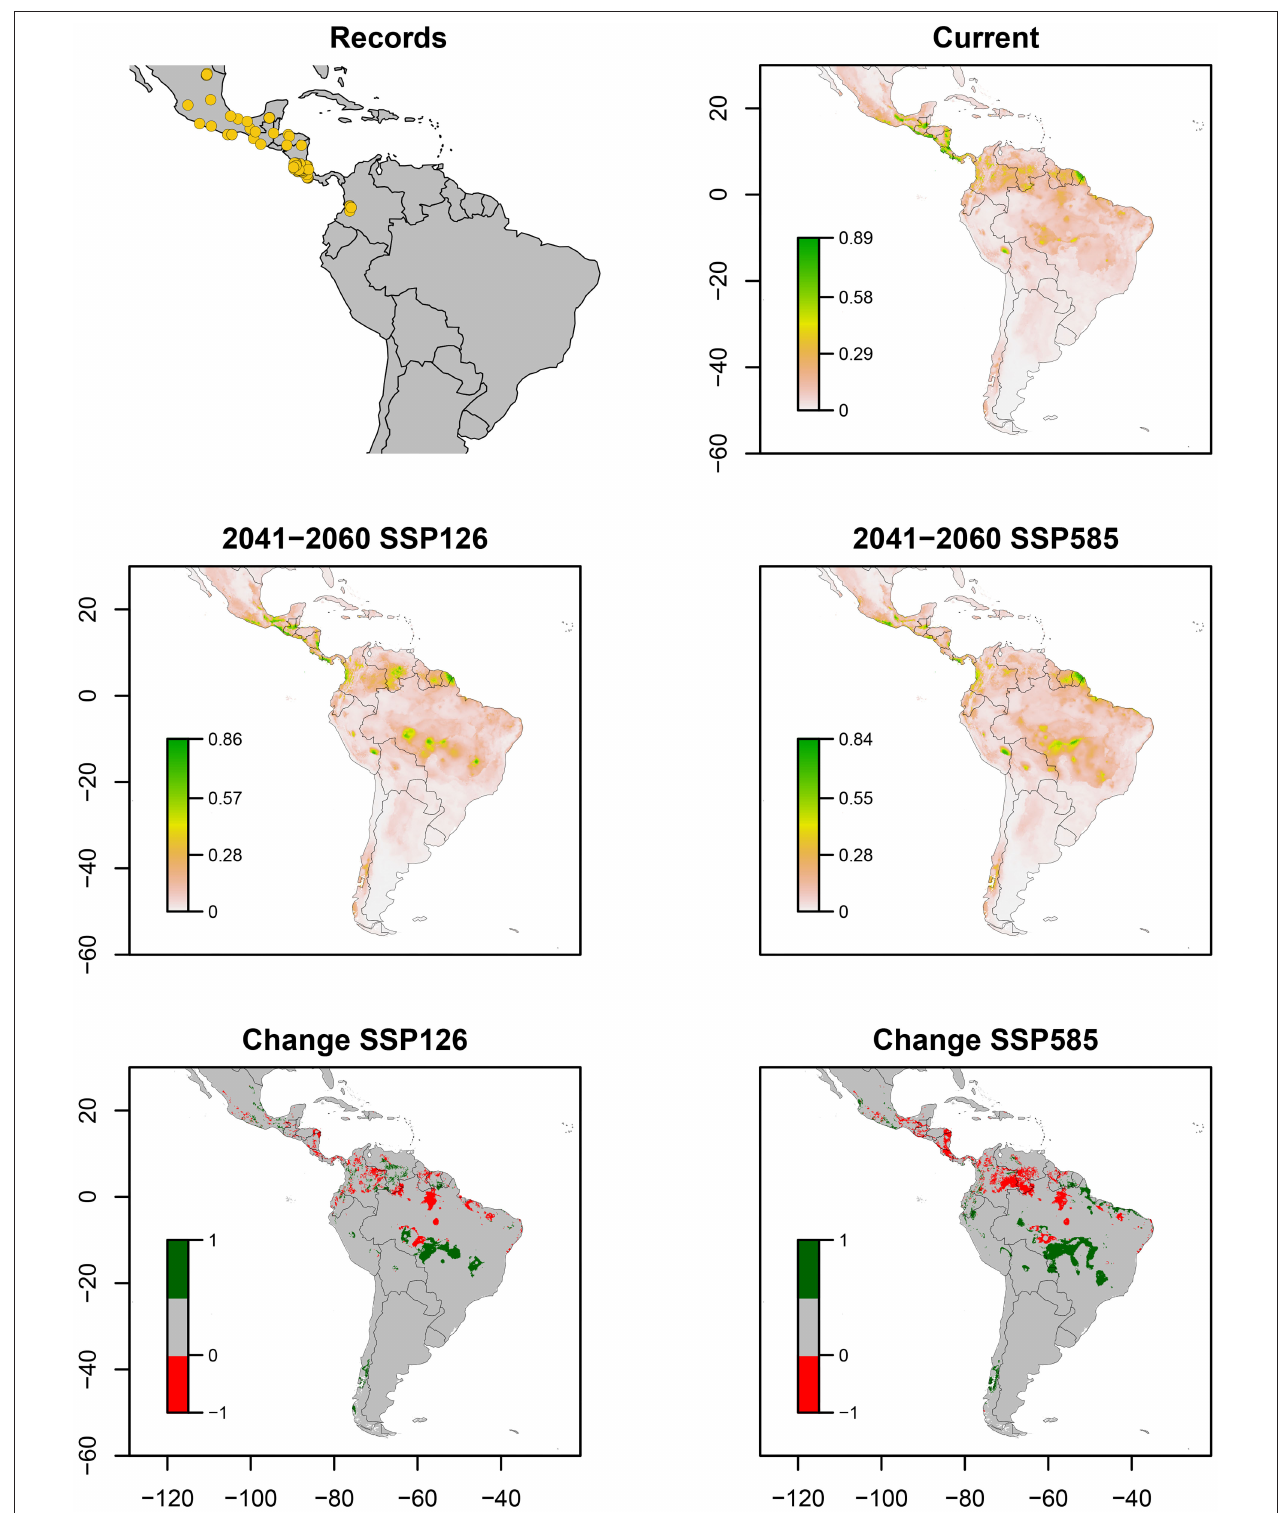
FIGURE 4 | Ecological niche models of Prosapia simulans. Distribution records, current potential distribution, future potential distribution (2041–2060) under SSP126 and SSP585 scenarios, and comparison between current and future scenarios (change SSP126 and SSP585). The scale shows the habitat suitability being 1 = higher suitability. Scale in change maps − 1 = possible extinction and 1 = possible